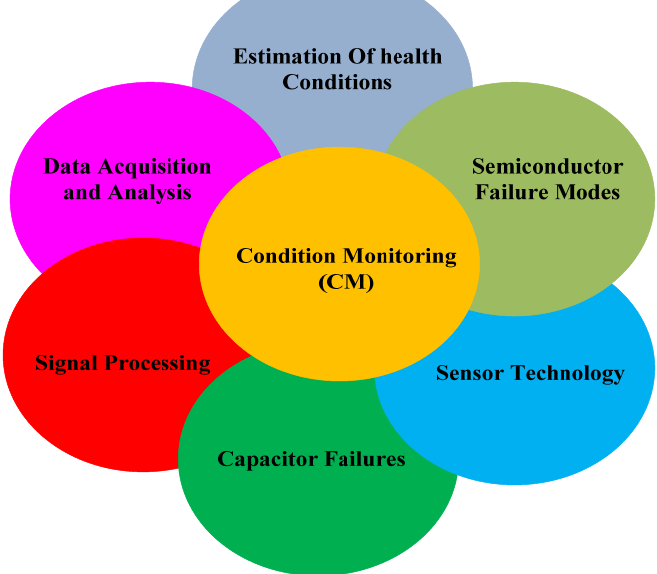
Figure 19. Conditioning Monitoring Domains for Power Electronics.